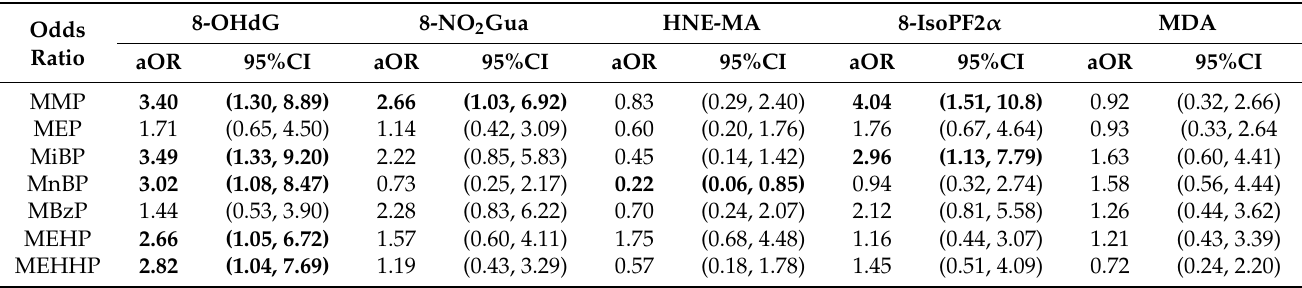
Table 6. Adjusted odds ratio for high oxidative/nitrosative stress biomarkers in the different urinary phthalate metabolite level (75th percentile)